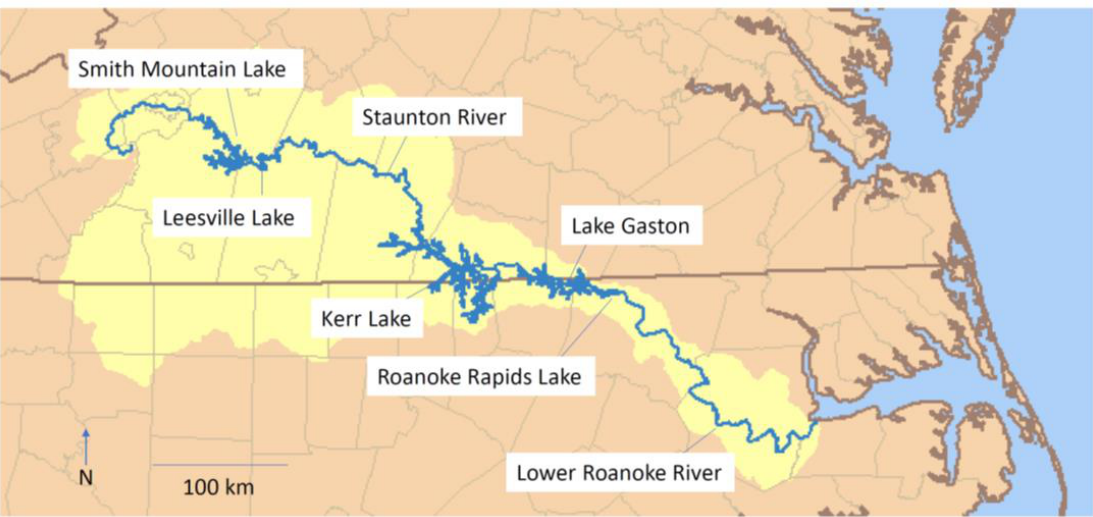
Figure 1. Roanoke River drainage, showing striped bass sampling sites in the states of Virginia and North Carolina. Base map by Pfly—Own work, CC BY-SA 2.5, https: // commons.wikimedia.org / w / index.php?curid =